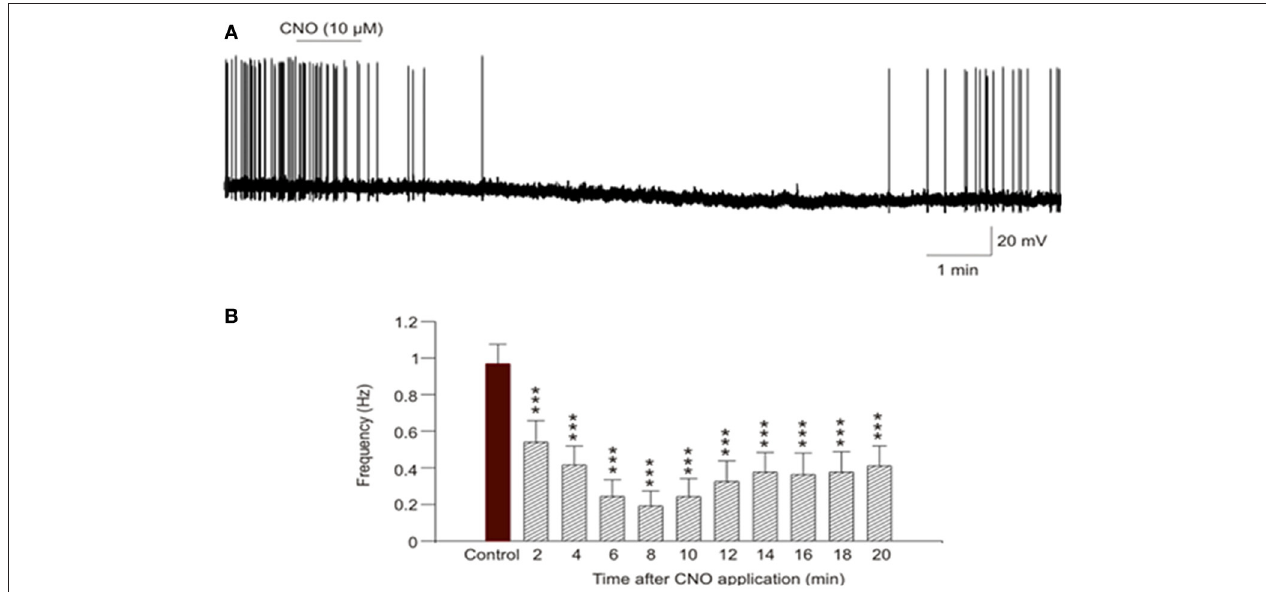
FIGURE 4 | In-vitro activation of hypoglossal neurons that contain inhibitory DREADDs. (A) Representative example demonstrates a depression of action potential firing of DREADDs-containing hypoglossal neuron recorded in current-clamp configuration after 1-min CNO (10 µ M) application. (B) The summary data from 7 neurons illustrate significant ( P < 0.001, 1-way ANOVA) inhibition of firing activity of hypoglossal neurons that started as early as 2min post CNO application and lasted for at least 20min post CNO application. *** P < 0.001.